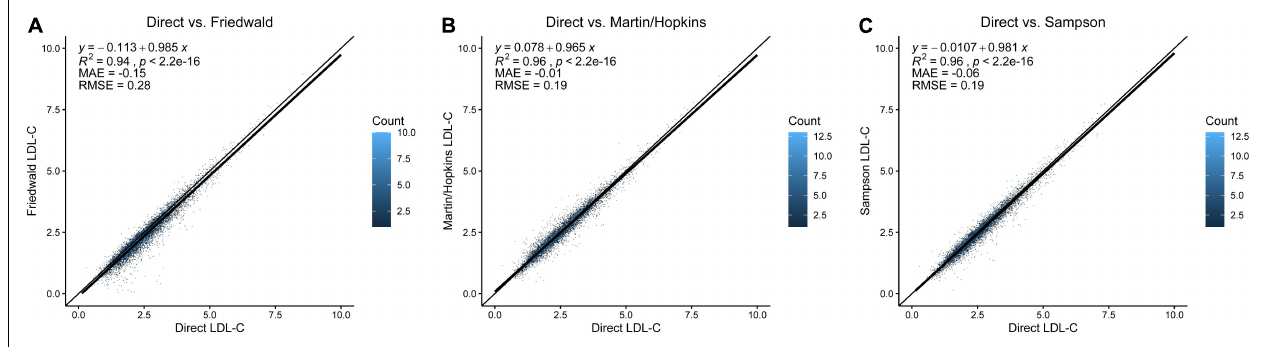
FIGURE 1 | Comparison of direct LDL-C and LDL-C equations. (A) Direct measurement vs. Friedewald equation. (B) Direct measurement vs. Martin/Hopkins equation. (C) Direct measurement vs. Sampson equation. The diagonal line is the unity line in each graph, where both equations estimate the same value. Each dot represents the estimated LDL-C by the respective equation indicated on the x - and y -axes. The dot’s color represents data density from light blue to dark blue. LDL-C, low-density lipoprotein